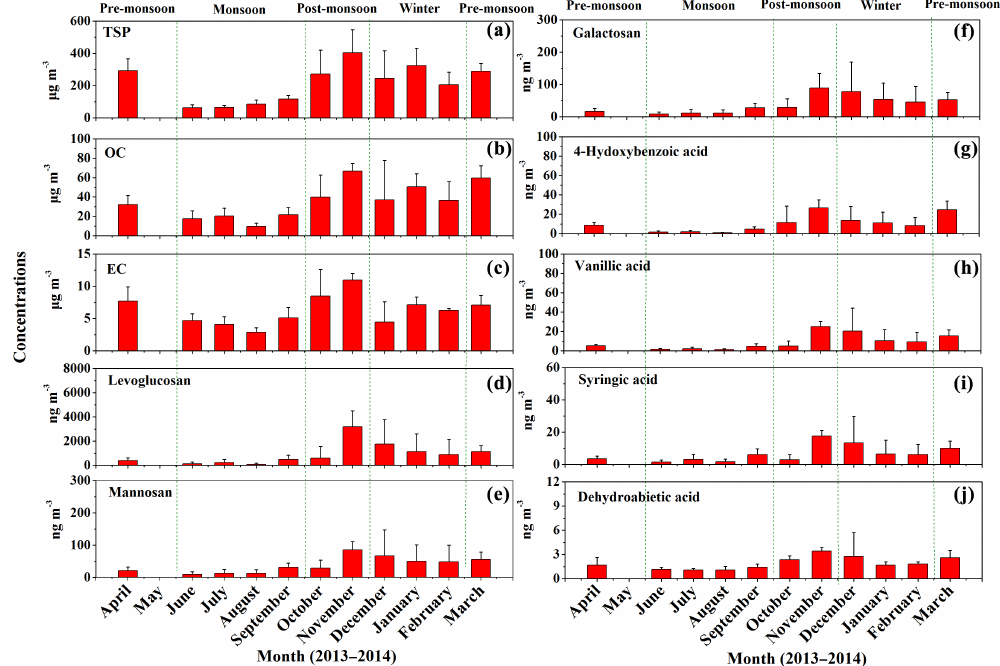
Figure 3. Seasonal variations in concentrations of TSP, OC, EC and organic tracers in aerosols collected in Lumbini from April 2013 to March 2014. The data of May 2013 are missing due to equipment